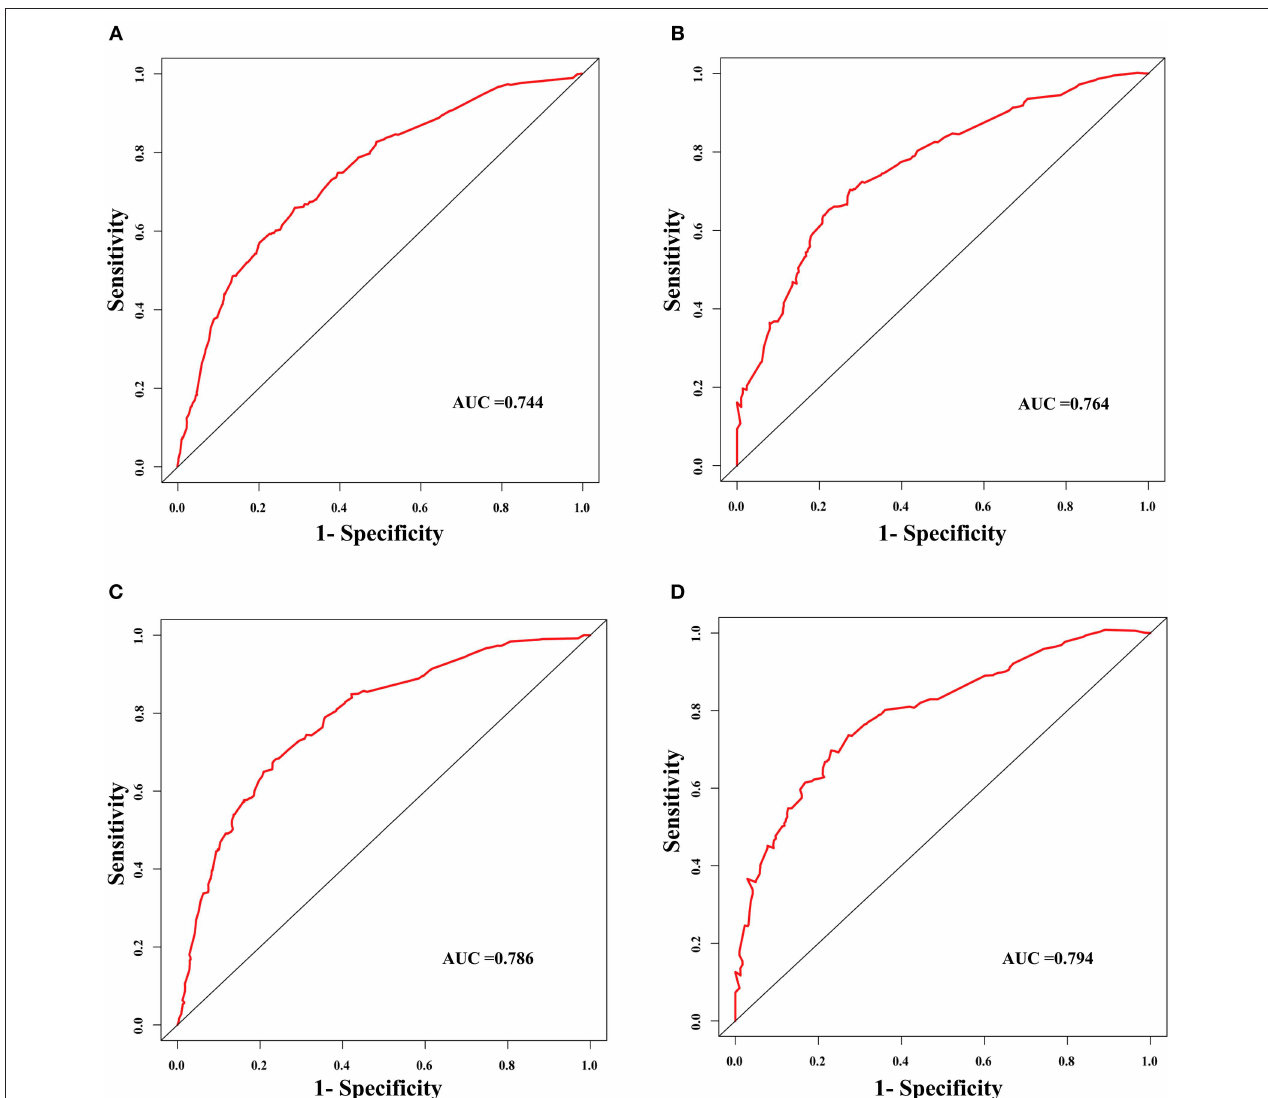
FIGURE 3 | The ROC curves of the nomogram for the prognostic prediction of early hepatocellular carcinoma. (A) For predicting 3-year survival in the training group. (B) For predicting 3-year survival in the validation group. (C) For predicting 5-year survival in the training group. (D) For predicting 5-year survival in the validation group. AUC, area under the receiver operating characteristic curve.